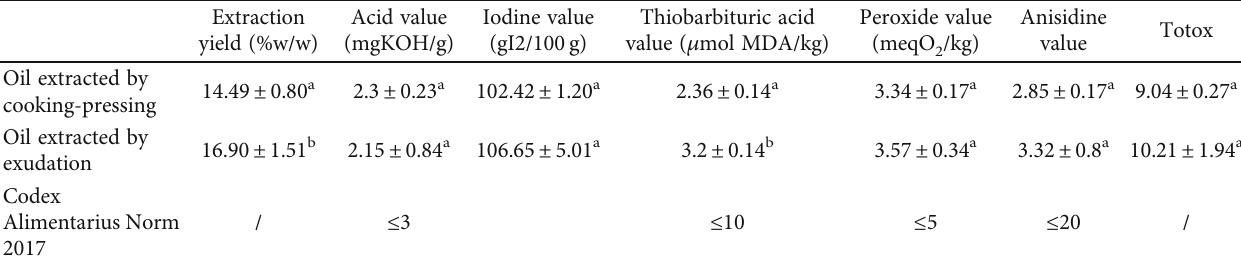
Table 1: Extraction yield and quality indexes of Fontitrygon margarita liver oil according to the extraction method.